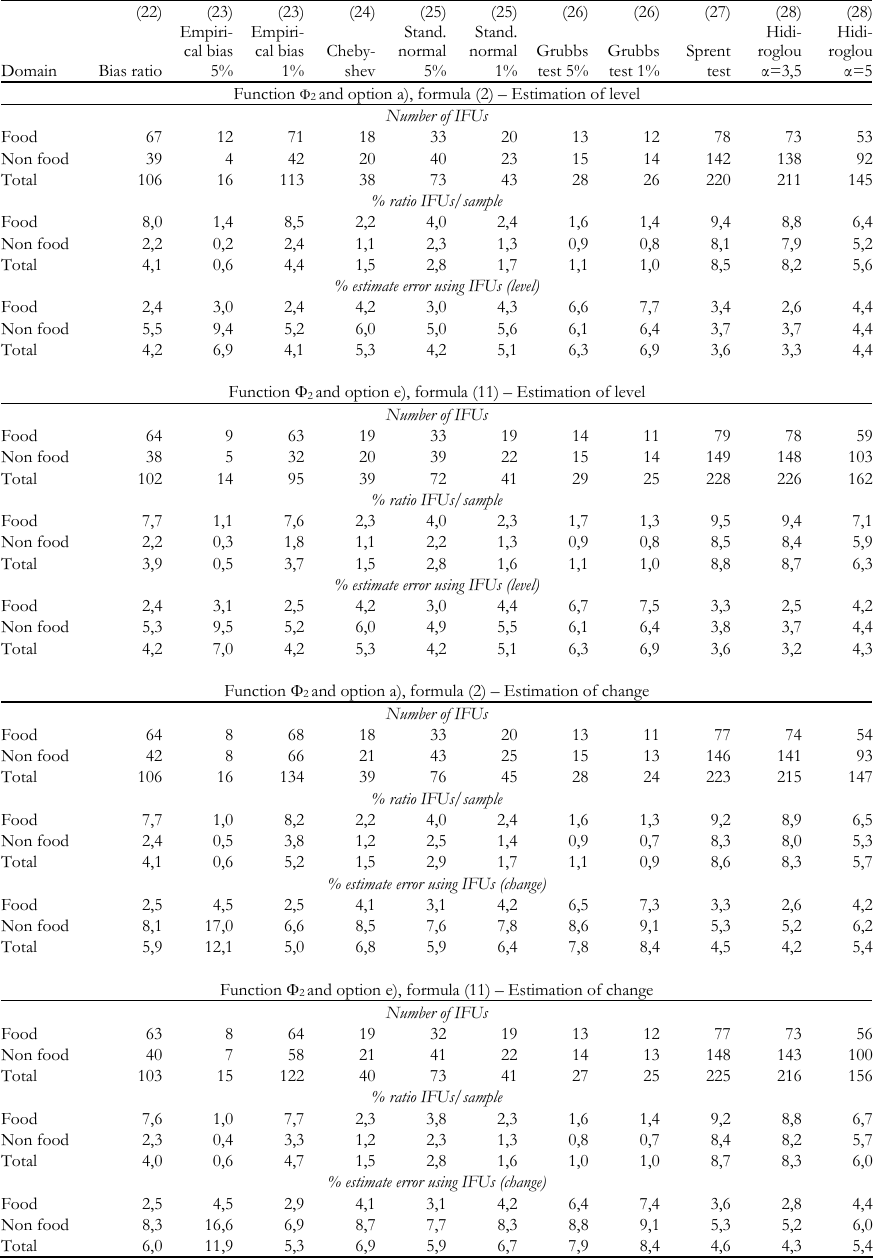
Main results using function Ф 2 with various criteria for estimating level and